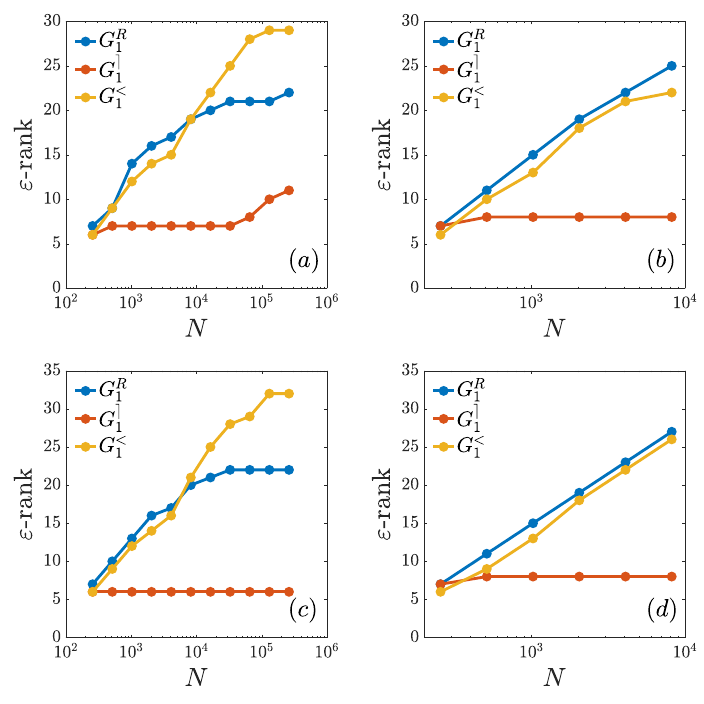
Figure 8: Ranks of the compressed representations for G tion times T corresponding to N time steps of fixed size ∆ t , and SVD truncation tolerance (cid:34) = 10 − 4 , for the ramp (first row, (a) & (b)), and Floquet (second row, (c) & (d)) examples. The first column ((a) & (c)) contains ranks computed on the fly, and the second ((b) & (d)) contains ranks computed offline for the smaller values of N